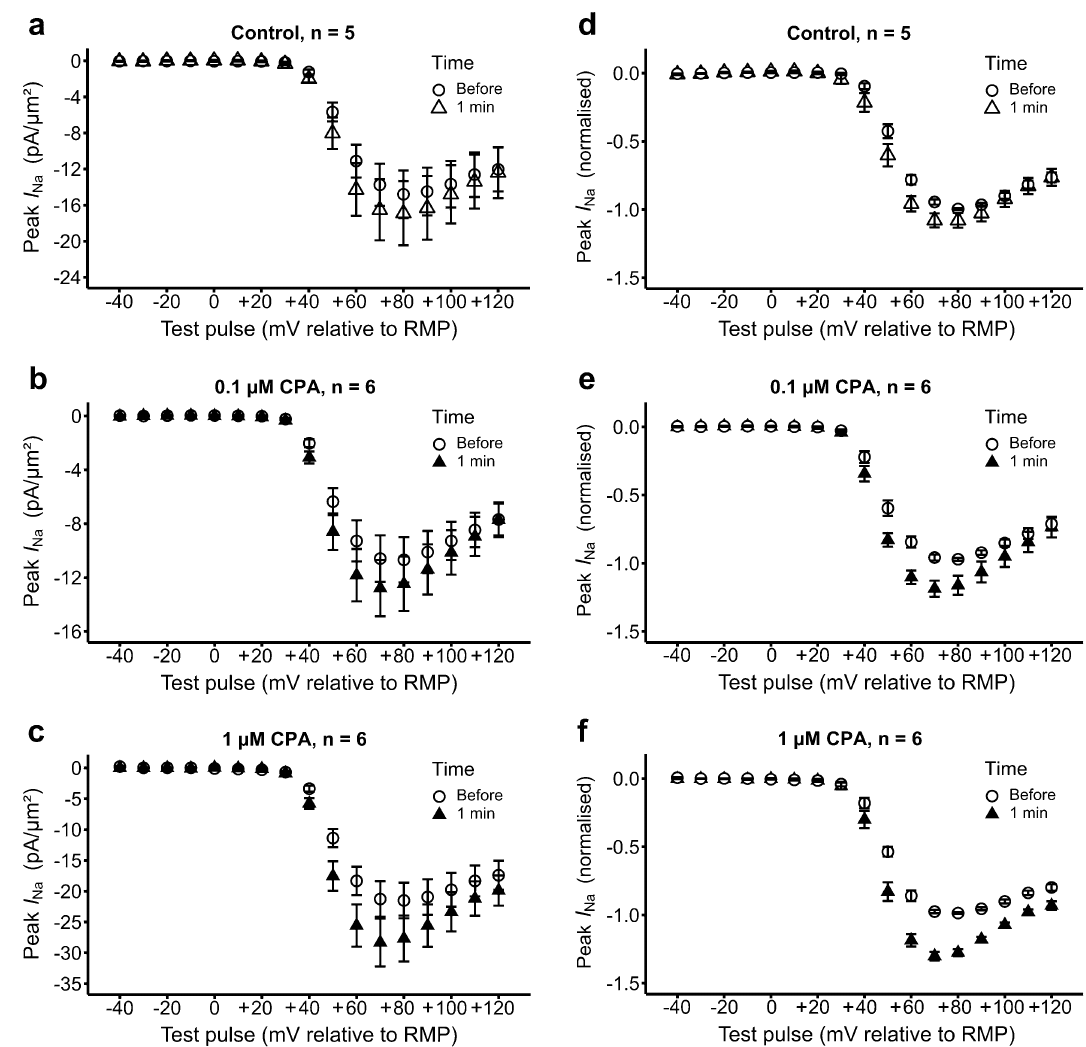
Figure 6. Comparison of current–voltage relationships through experimental manoeuvres. Mean (± SEM) peak currents from all patches plotted against voltage excursion giving I–V relationships, comparing measurements before and 1 min after solution change to one containing ( a , d ) 0 µM, ( b , e ) 0.1 µM CPA and ( c , f ) 1 µM CPA. Left panels ( a – c ) show comparisons of mean values of the observed currents with error bars representing standard errors of the mean (SEM) obtained from between-patch, unpaired, comparisons. Right panels ( d – f ) show I–V relationships normalized to maximum peak currents for each individual patch prior to CPA challenge thereby correcting for between-patch variations in peak current, representing their means and SEMs. Numbers of different patches ( n value) are indicated above each graph; each patch contributed two measurements at a given voltage as part of sequences imposing progressively increasing and decreasing voltage